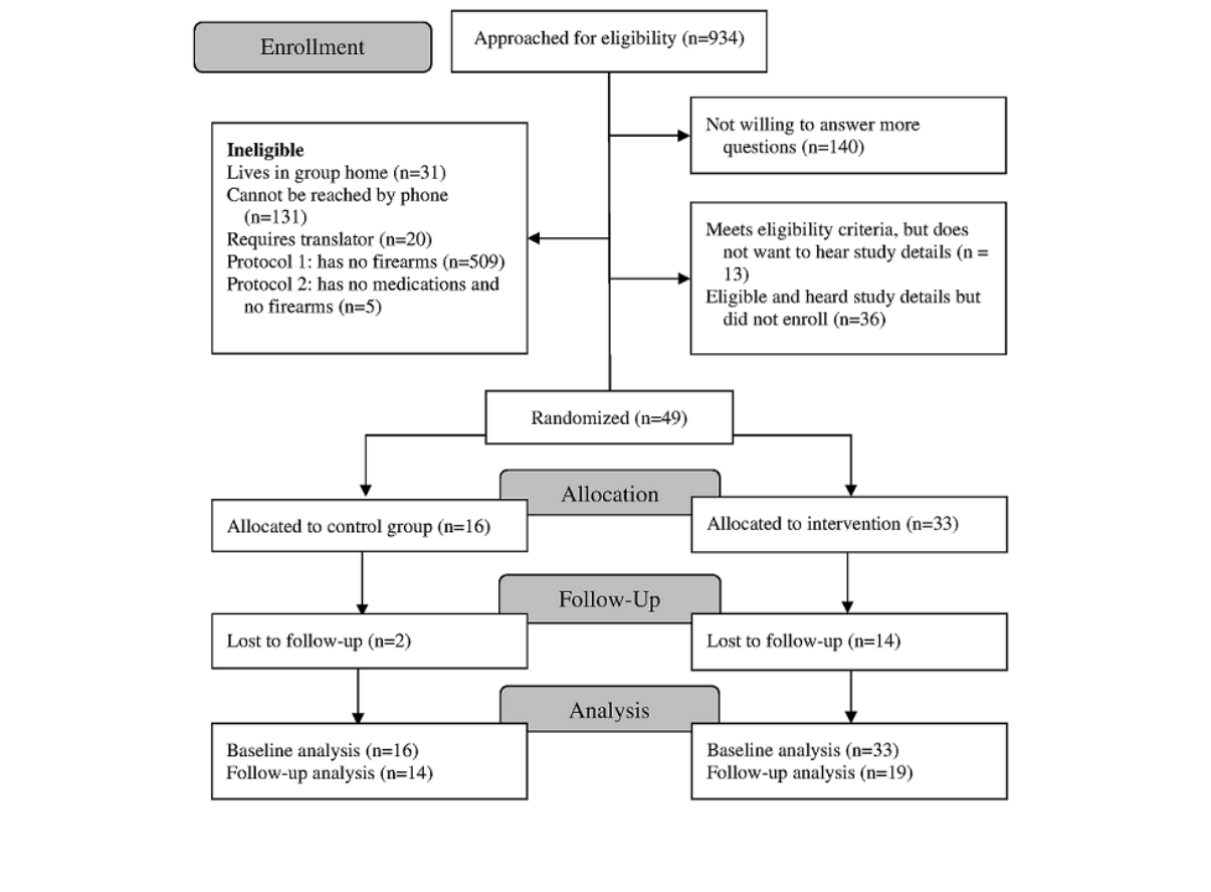
Figure 1. Consolidated Standards of Reporting Trials